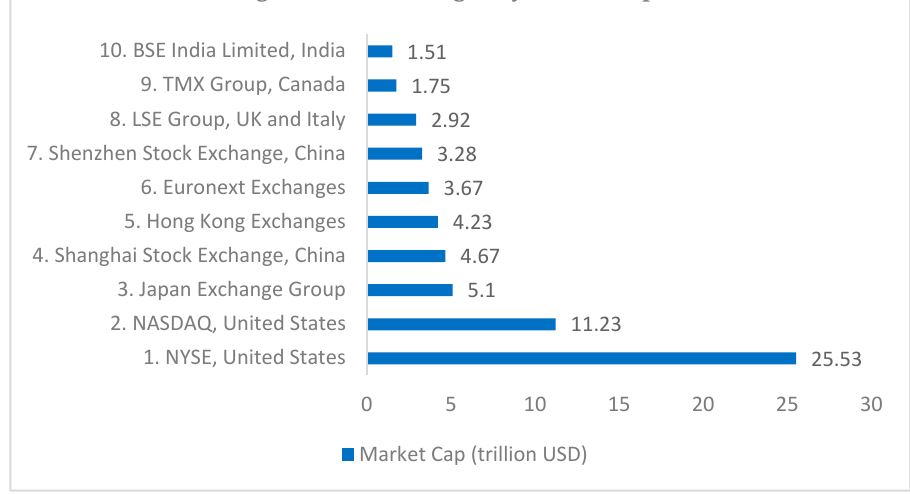
Figure 3. World largest stock exchanges by market. Source: Szmigiera [41]. Table 1. Descriptive Statistics.